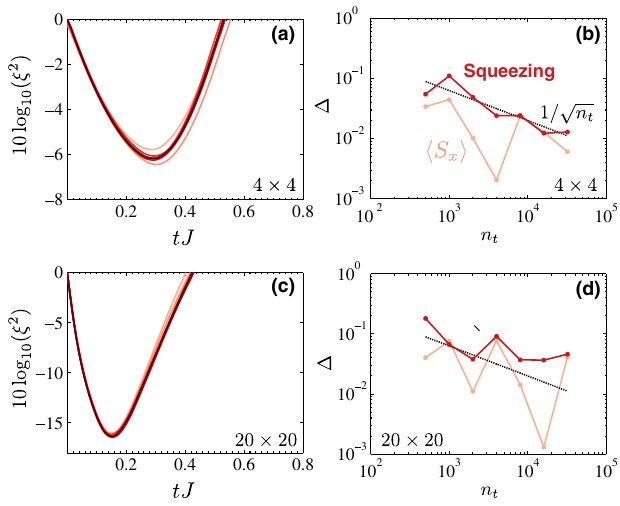
FIG. 6. Statistical convergence. (a),(c) Time evolution of the squeezing parameter in DTWA for different number of trajectories: n t ¼ 500 , 1000, 2000, 4000, 8000, 16 000, 32 000, 64 000 from light to dark. (a) Small 4 × 4 system with XY interactions ( α ¼ 1 ). (c) 20 × 20 system. In both cases, for n > 4000 , curves are essentially indistinguishable. Panels t (b),(d) show the maximum relative difference of the calculations from the n t ¼ 64 000 result. The upper line is for the spin- squeezing parameter, the lower line for h S x i ; there are smaller relative differences for this simple observable. Both differences ffiffiffiffi p n decrease as 1 = (dashed line) as expected. Panels (b) and (d) t are for the small and large system,